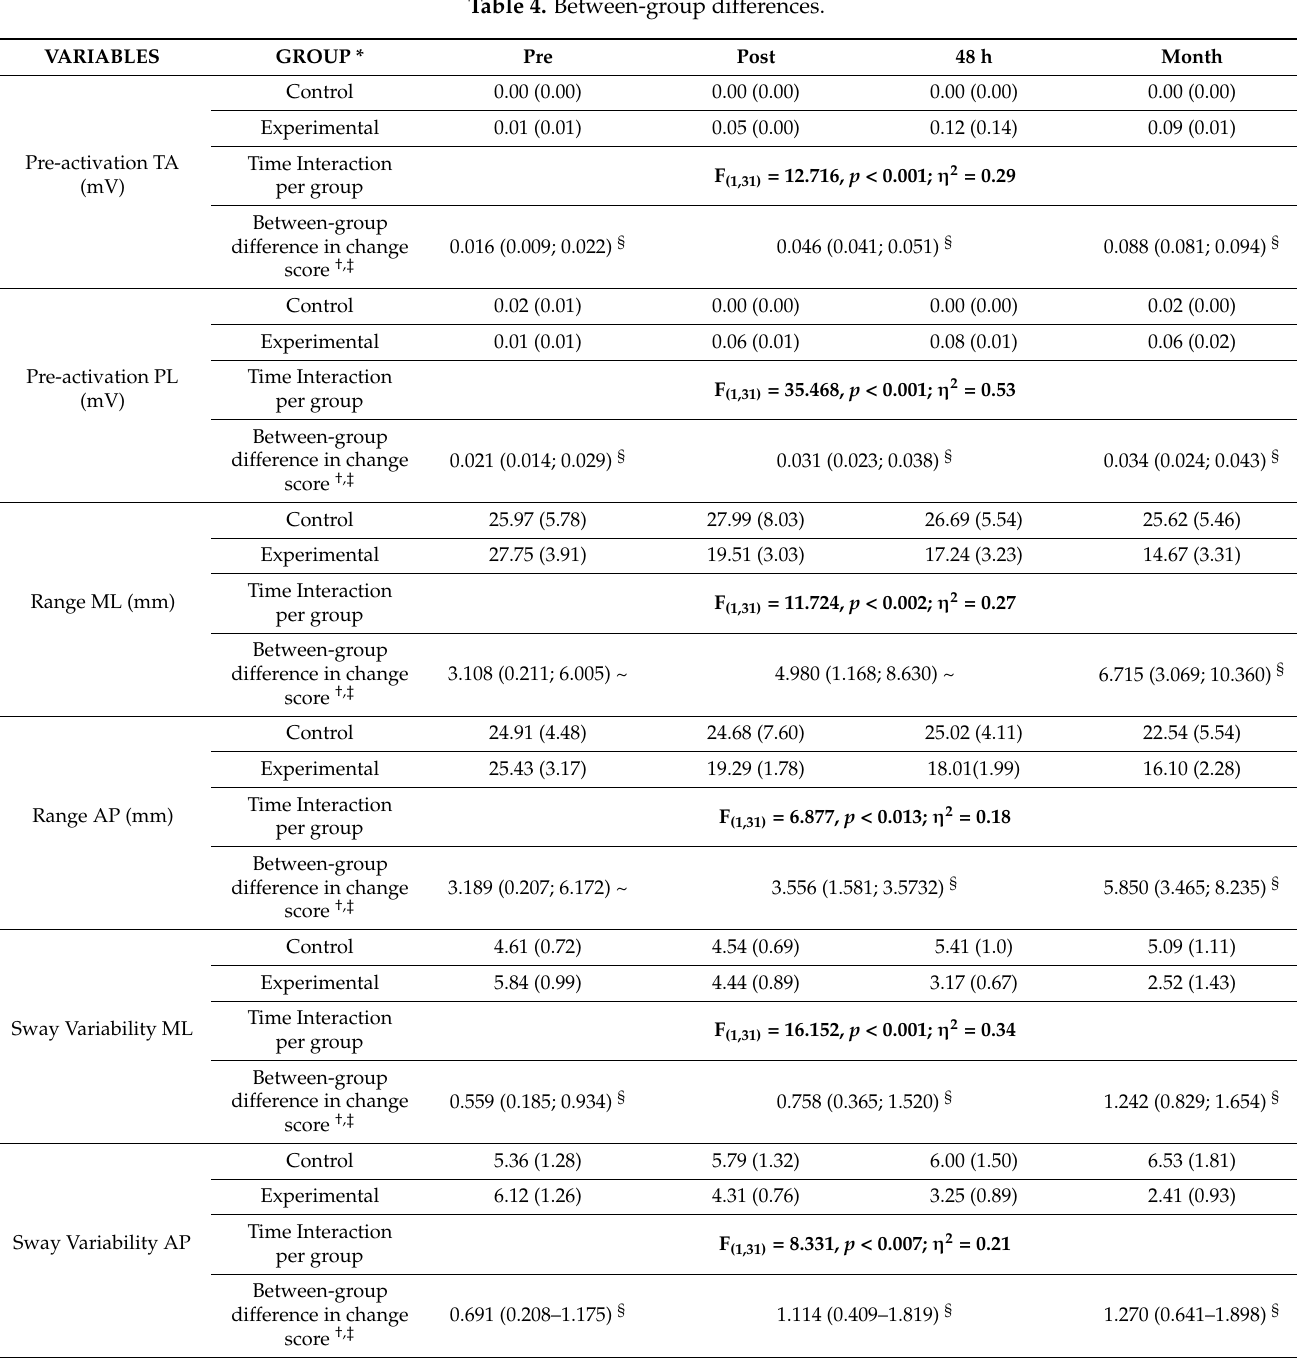
Table 4. Between-group